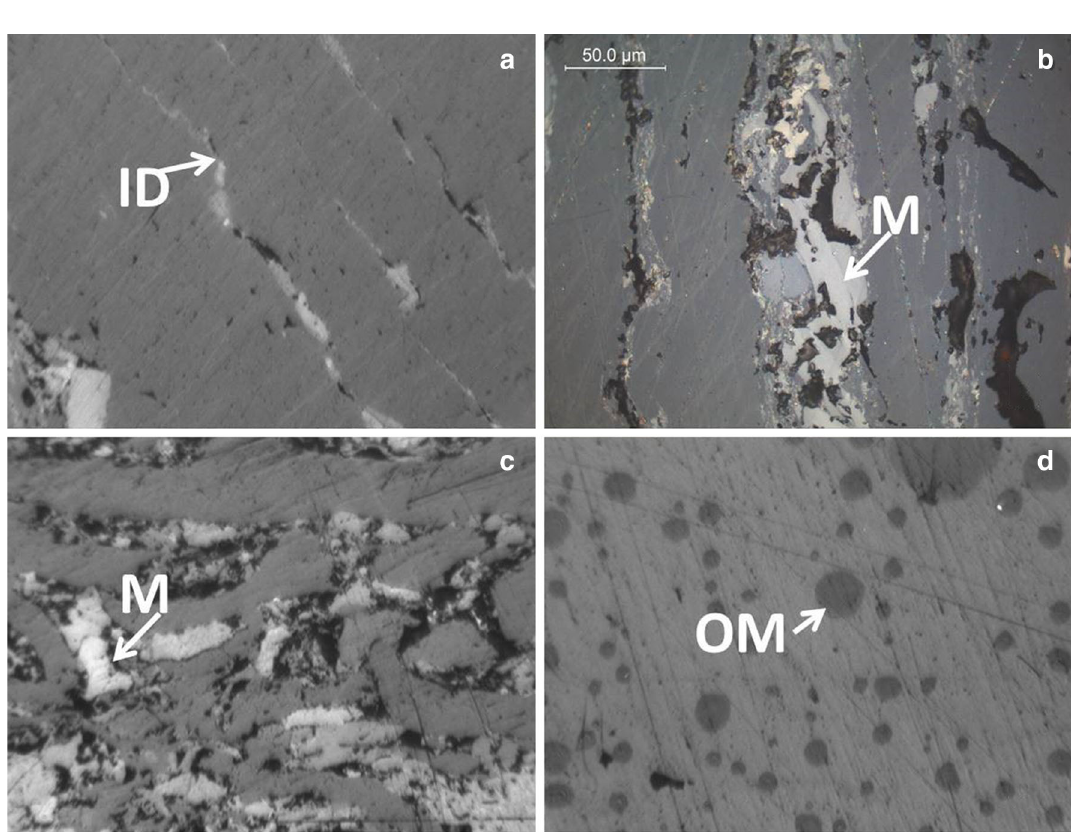
Fig. 1 Photomicrographs of occurrence of barkinite with other macerals of samples. a barkinite with inertodetrinite (ID); b , c barkinite with macrinite (M); d oil matter (OM) in barkinite. (These photos were observed under white light irradiation)